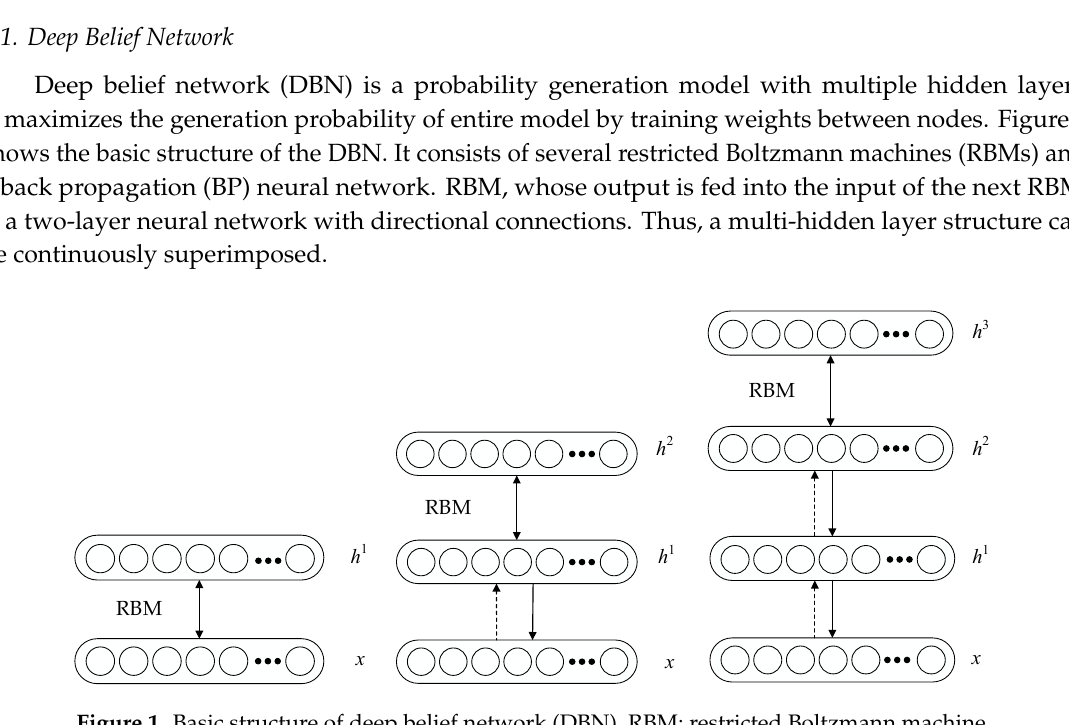
Figure 1. Basic structure of deep belief network (DBN). RBM: restricted Boltzmann machine.